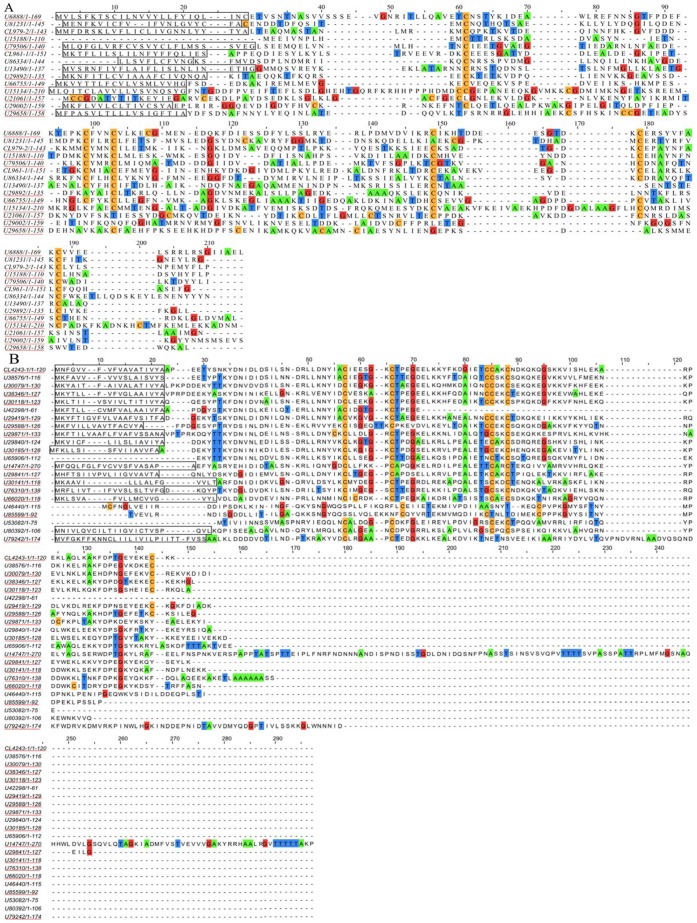
Alignment of amino acid sequences of the candidate OBPs and CSPs.(A): Alignment of amino acid sequences of the candidate OBPs. (B): Alignment of amino acid sequences of the candidate CSPs. Predicted signal peptides are boxed, and the conserved cysteines are highlighted in blue. Sequences which contained a full length open reading frame were labeled by red line.